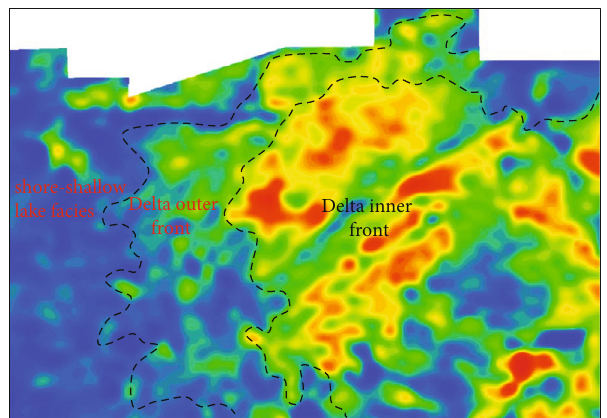
Figure 18: Seismic facies planar distribution of the Cretaceous Baxigai Formation in the Yudong-Yingmaili